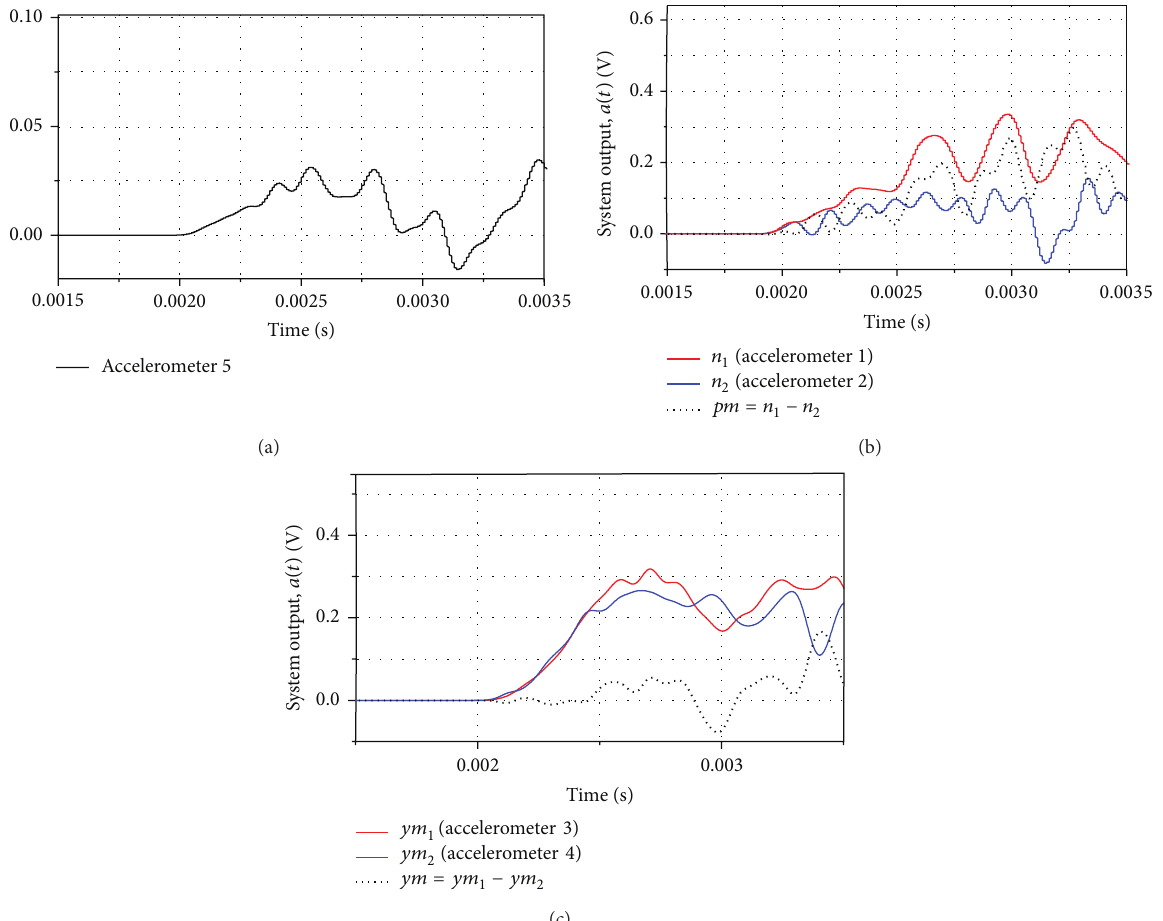
Figure 7: Typical system output obtained during shock tunnel testing. (a) Side force, (b) pitching, and (c) yawing components. AOA = 15 ∘ .